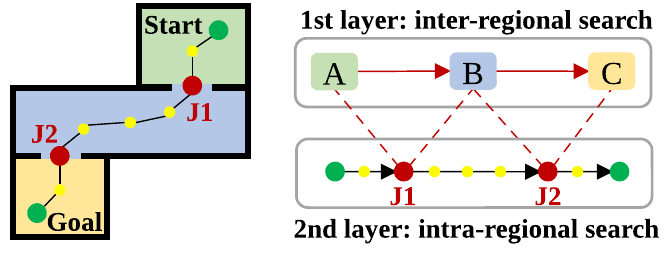
Figure 1. Hierarchical